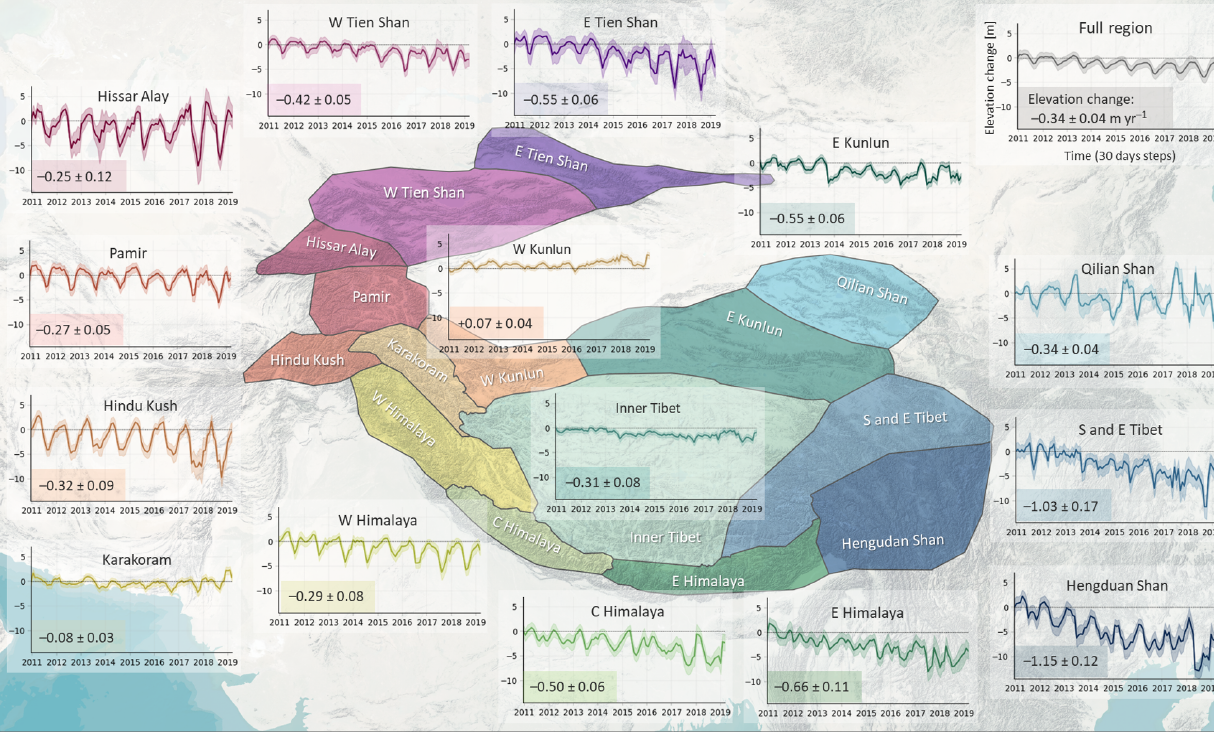
Figure 5. High Mountain Asia (HMA) 30d elevation change time series in the RGI 6.0 second-order regions. The coloured line displays the time series with the uncertainty envelope ( y axis: elevation change [m]; x axis: time [30d steps]). The numbers describe the elevation change with uncertainties in myr − 1